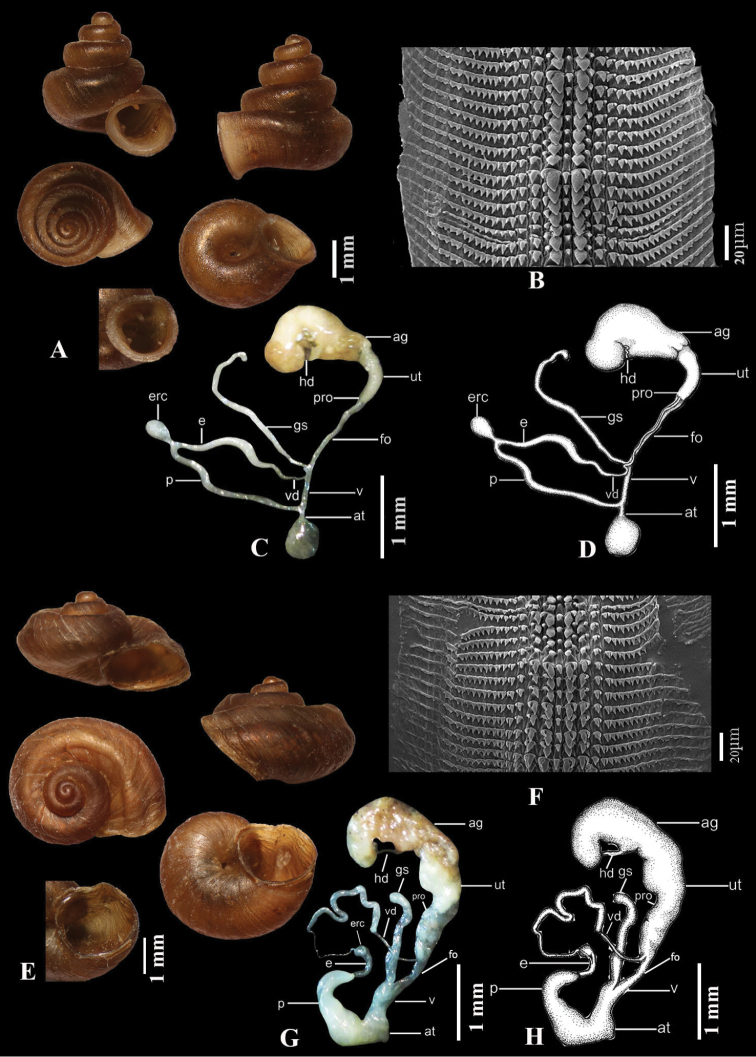
A–DAulacospira
pluangtong (ZRCBUU 357) A shell B radula C, D genital system E–HAulacospira
nutadhirai sp. nov. E holotype (ZRCBUU 0391) F radula G, H genital system.